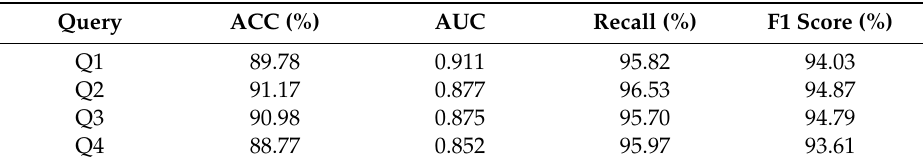
Table 5. The result of evaluating performance of the proposed model on test dataset collected through queries from the same domain i.e., Kidney.